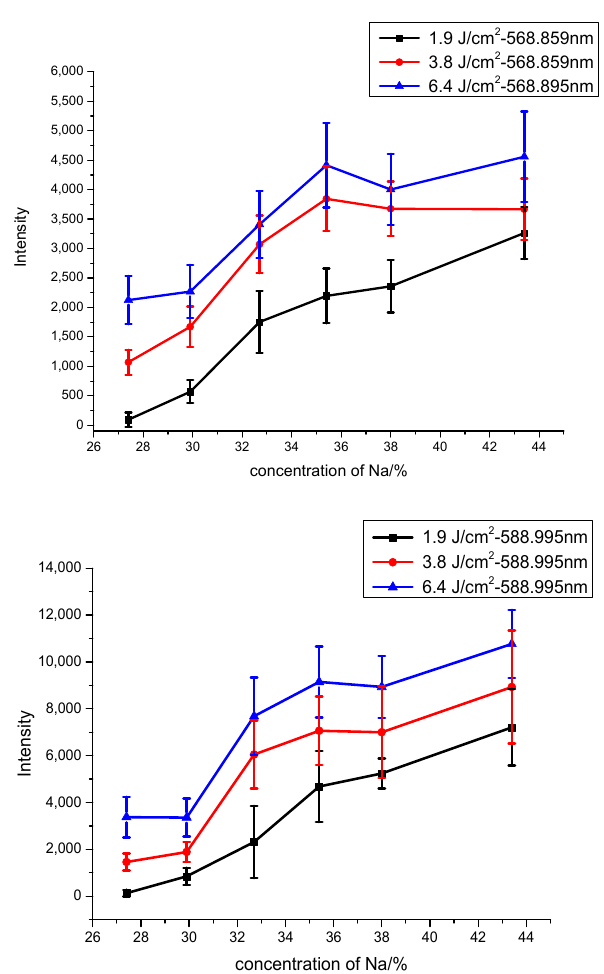
Figure 4. Emission intensity under varying concentrations of Na as a function of laser energy. Signals obtained from the Na I 588.995 nm, Na I 568.859 nm are shown.